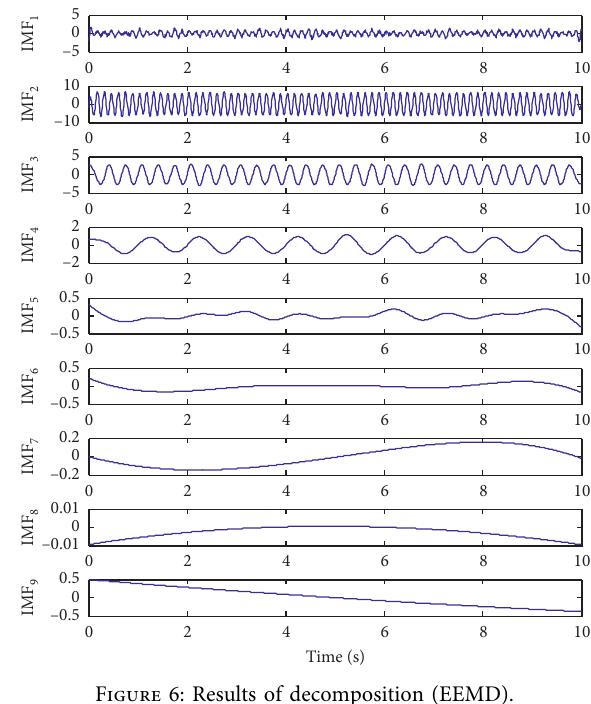
Figure 6: Results of decomposition (EEMD).